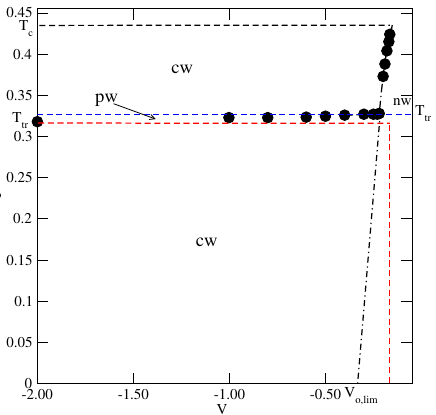
Figure 14. The main part shows adsorption isotherms for the system with u ∗ = − 0.2 and V o = − 0.22, recorded at different temperatures (given in the figure). The lower and upper insets show the density profiles ρ ( z ) (filled circles) and ρ k ( z ) (open symbols) recorded at T = 0.31 and µ = − 1.2877 and at T = 0.34 and µ = − 1.2698, respectively.